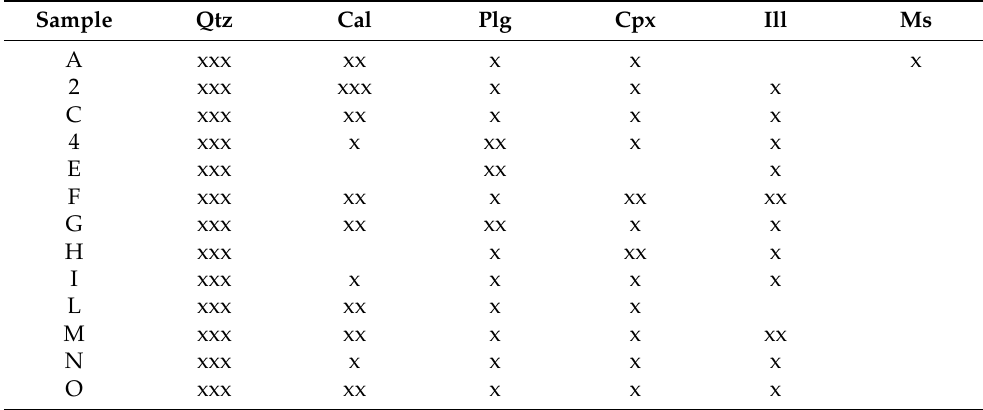
Table 1. Semiquantitative summary of the mineralogical phases present in the terracotta. Legend: XXX = abundant (100–50 wt%); XX = common (50–30 wt%); X = scarce (30–5 wt%). (Qtz: quartz;